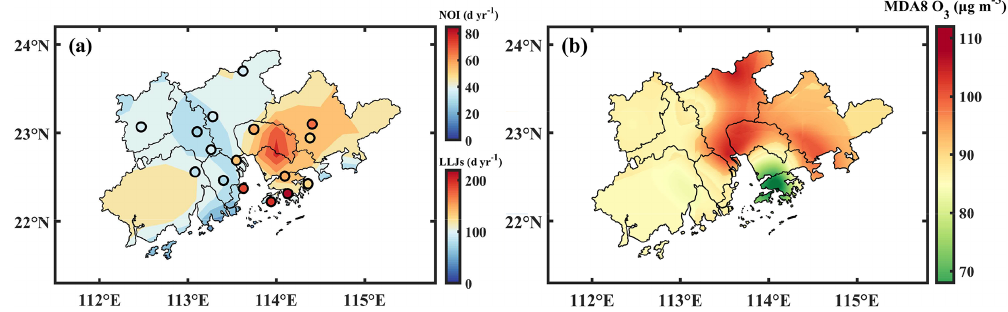
Figure 7. Spatial distribution of annual average (a) NOI event frequency (points) and LLJs frequency (contours) and (b) MDA8 O 3 concen-